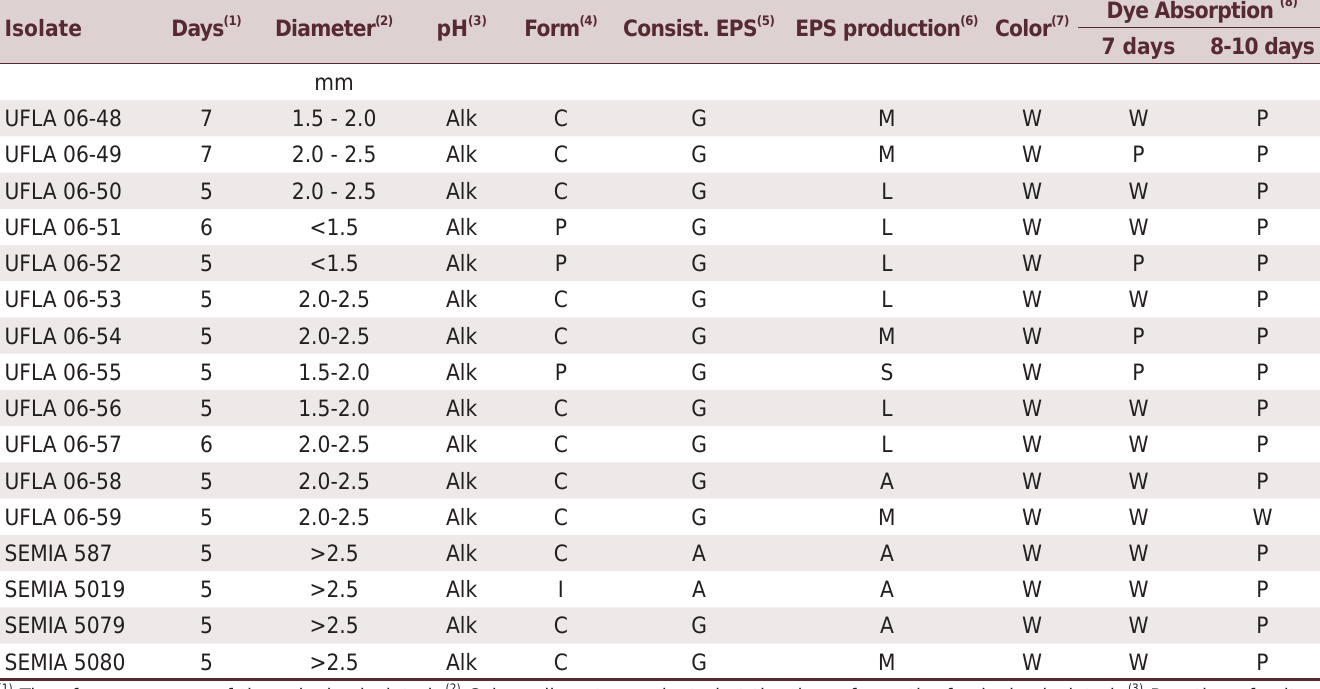
Table 2. Cultural characterization of inoculant strains and of variant colonies isolated from commercial soybean inoculants in solid medium, with bromothymol blue or Congo red dye